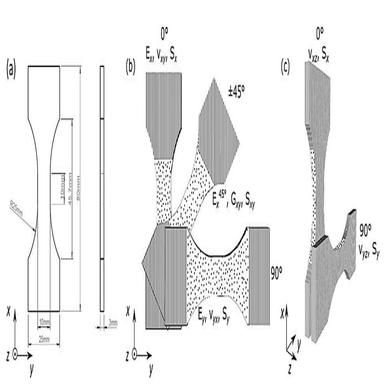
Tensile test specimen dimensions (a) and a representation of 3D-printed specimens with an applied stochastic dot pattern to obtain strains from covered surfaces with digital image correlation in the xy - (b) and xz -plane (c). The ± 45°, 0°, and 90° strand orientations are indicated in (b) and (c). The obtained engineering constants from each orientation are highlighted below each sample in (b) and (c). ( S S S , , xy x y) refer to tensile strength of ± 45°, 0°, and 90° specimens, respectively. The coordina